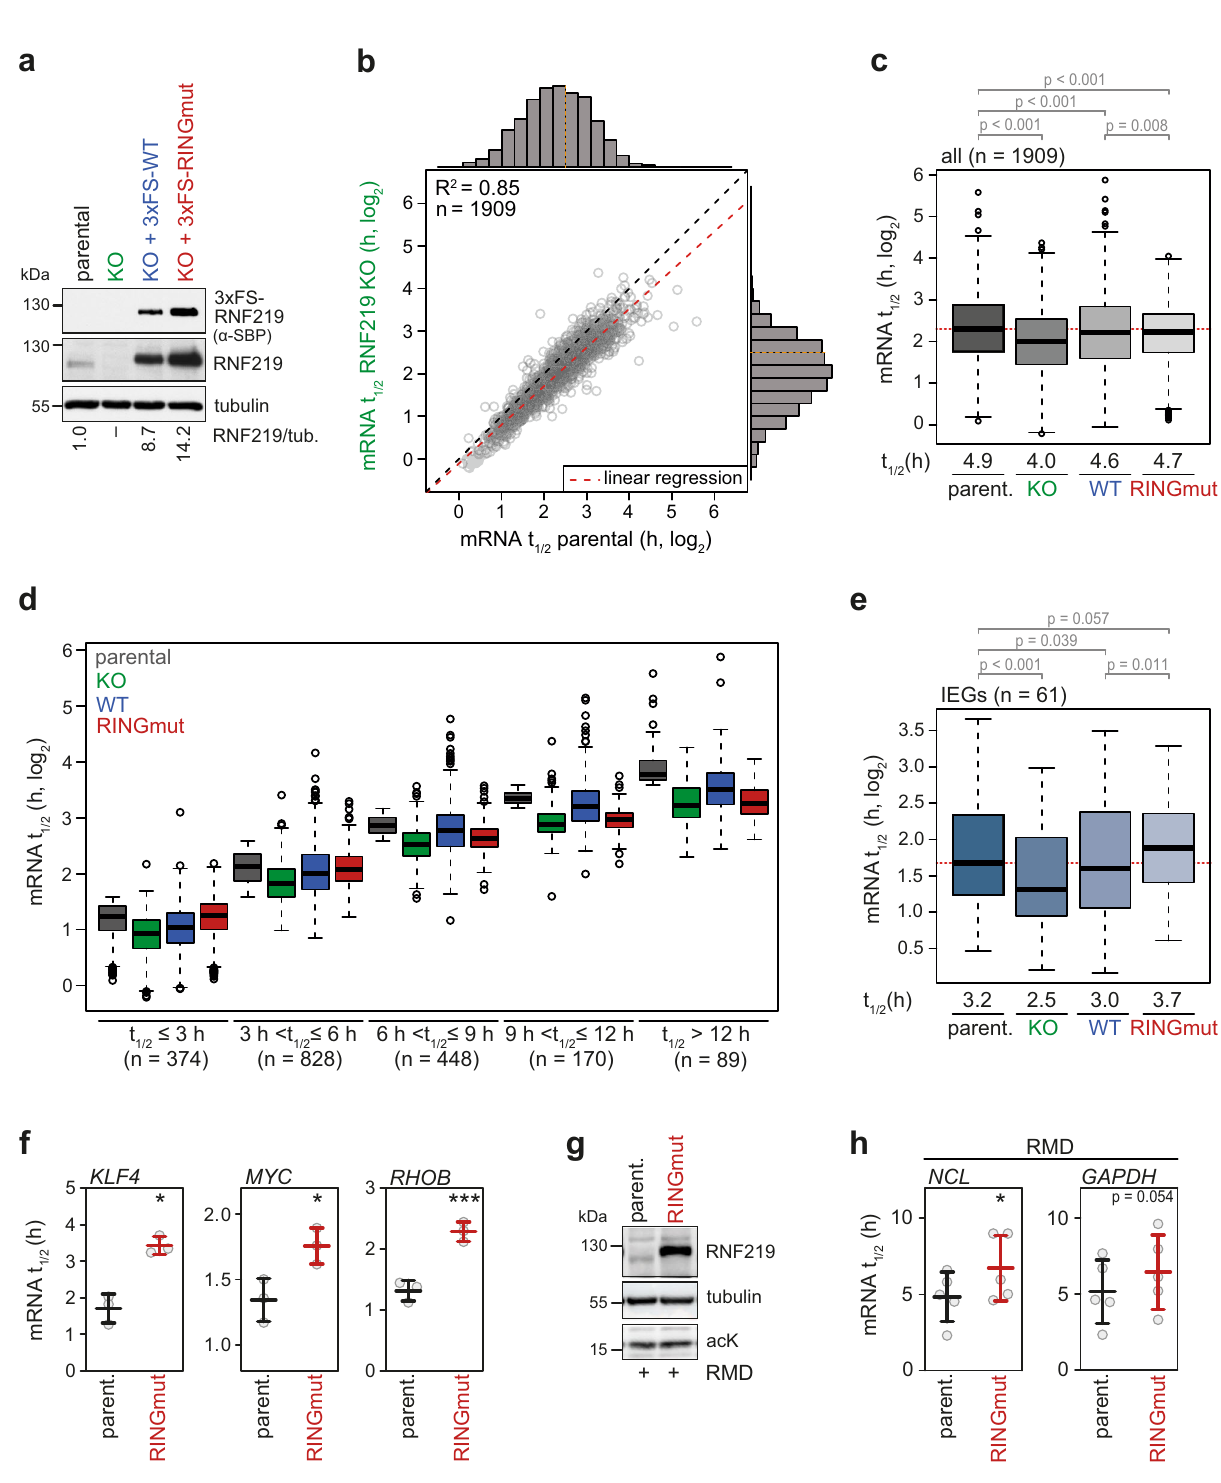
Fig. 6 The SLiM is essential for the inhibitory function of RNF219. a Schematic illustration of the domain architecture of RNF219; RNF219-C (residues 434-726), RNF219 434-600, RNF219 434-600 Δ SLiM and RNF219 434-600 SLiM-3E are shown below. Mutated amino acid residues in RNF219 434-600 SLiM-3E are highlighted in red. b Coomassie-stained polyacrylamide gel of in vitro pull-down assays with MBP-Strep alone or four recombinant RNF219 constructs fused to MBP and a StrepII (Strep) af fi nity tag after incubation with the NOT9 module. c In vitro deadenylation assay with 50 nM of a 7-mer-A 20 RNA substrate, 50 nM CCR4-NOT MINI complex and 2250 nM of MBP-Strep or indicated MBP-RNF219 constructs. Reactions were stopped at the indicated time points and analyzed by electrophoresis using a 20% denaturing polyacrylamide gel; M, RNA size marker; C, RNA alone control. d Quanti fi cation of the change in poly(A) tail length by plotting the most abundant tail length at each time point. Linear regression was used to determine the apparent deadenylation rate (As/min); values are presented as mean ± SE ( n = 3). Source data for panels ( b – d ) are provided as a Source Data fi